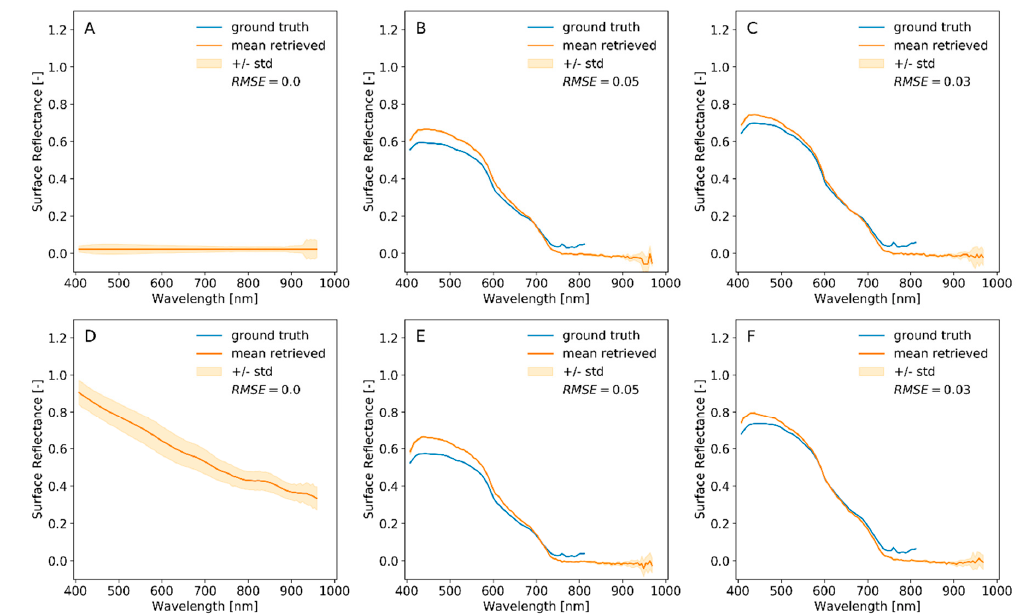
Figure 7. Comparison between empirical line calibration and field spectra for the dark ( A ) and bright ( D ) targets and four melt pond bu ff ers ( B , C , E , F ). RMSE is computed for the overlapping wavelength regions, respectively.